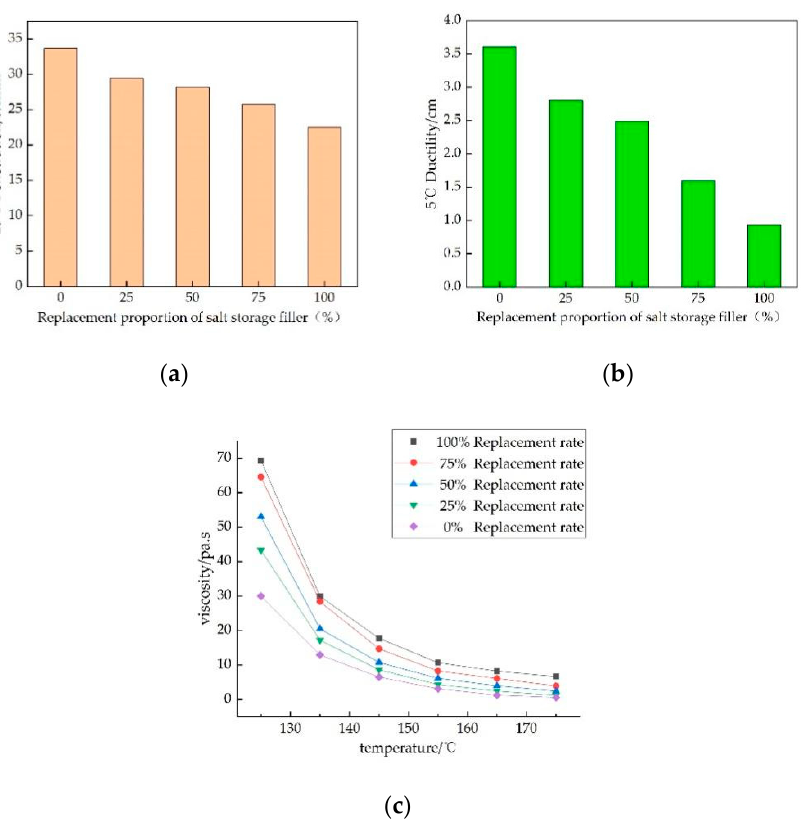
Figure 2. The performance of asphalt mortar varies with the amount of salt storage filler: ( a ) 25 °C penetration test; ( b ) 5 °C ductility test; ( c ) Brinell viscosity test. penetration test; ( b ) 5 ◦ C ductility test; ( c ) Brinell viscosity